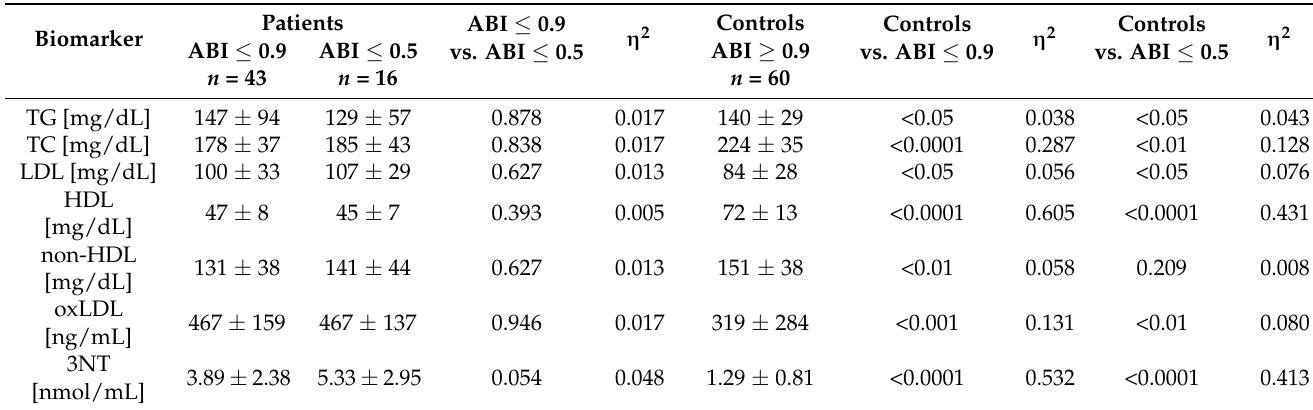
Table 3. Atherogenic markers (mean ± SD).